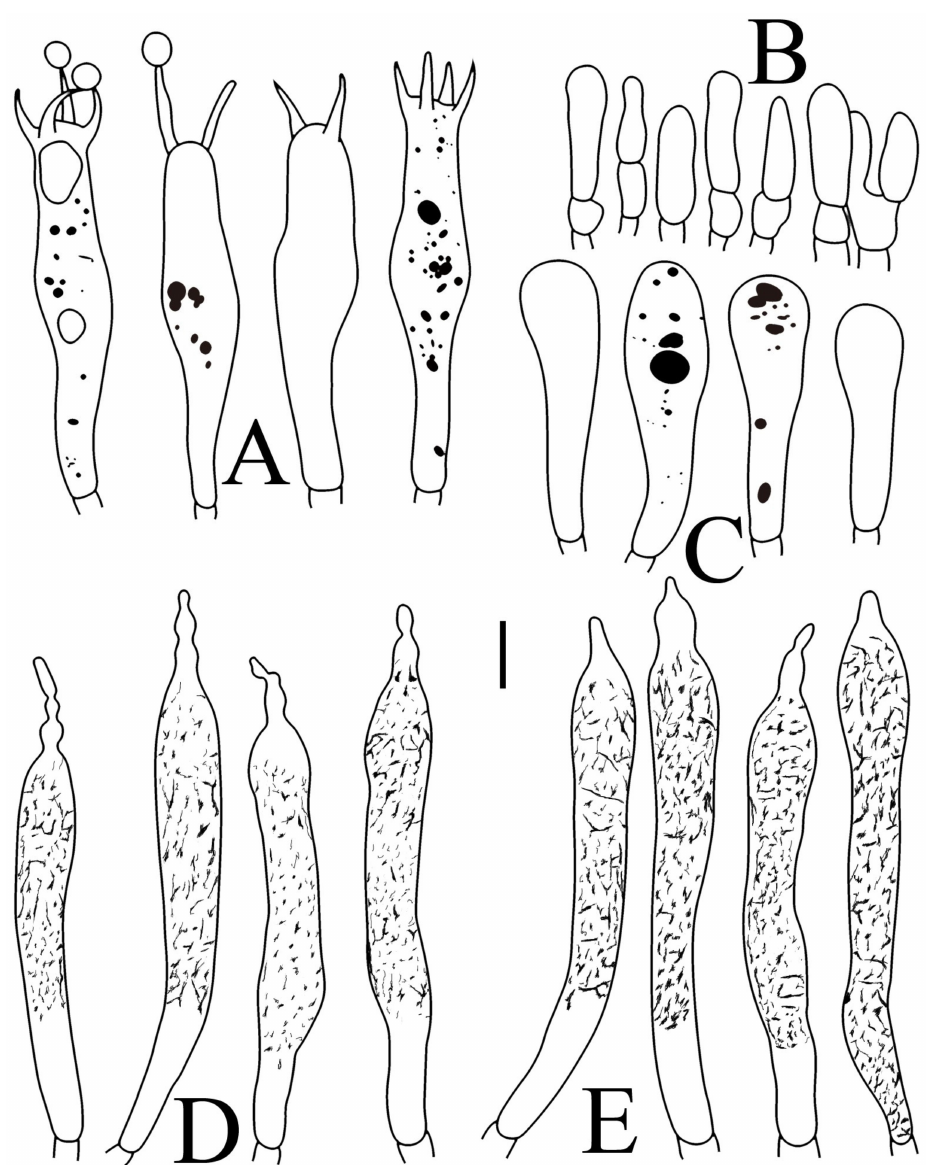
Figure 8. Russula longicollis (RITF5685, holotype): ( A ) basidia; ( B ) marginal cells; ( C ) basidiola; ( D ) hymenial cystidia on lamellae edges; ( E ) hymenial cystidia on lamellae sides. Scale bars: 10 µ